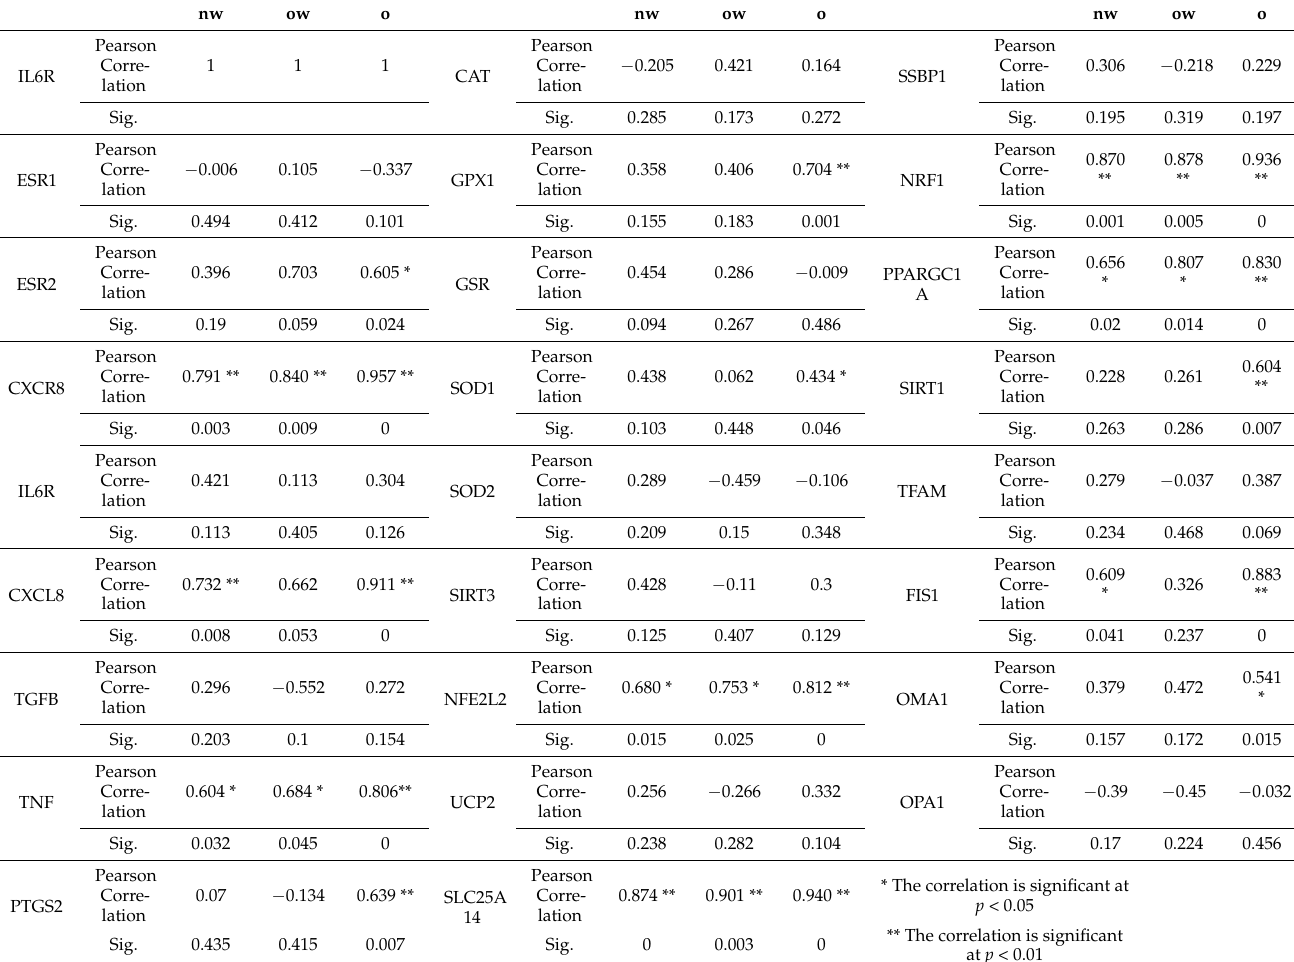
Table 5. Correlation values of IL6R gene expression in breast tumors according to obesity